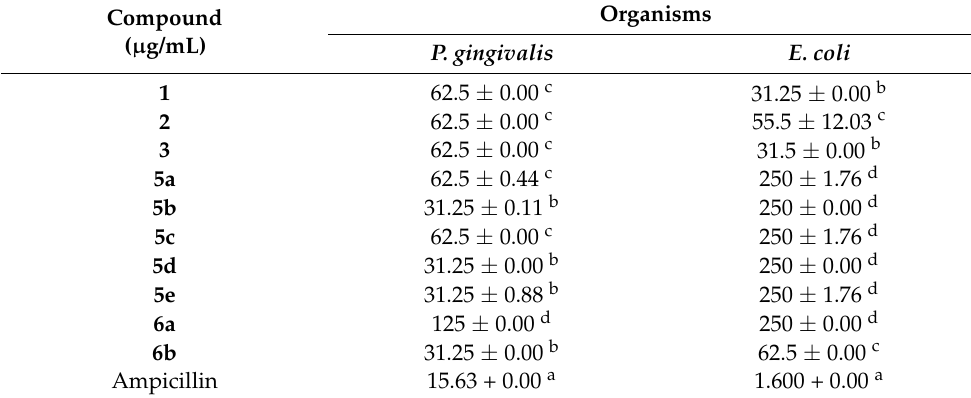
Table 1. MIC values of synthesized compounds .